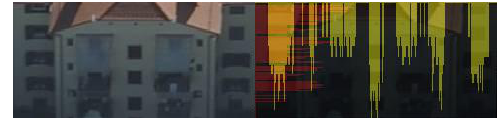
Figure 3: To the left is a rectified facade image with a depth structure, to the right a failed count of windows. The 3D structure needs to get considered.